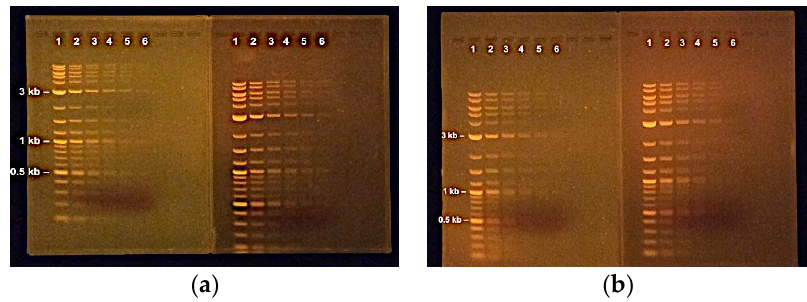
Figure 5. Use of recycled agarose. Pairs of 1% agarose/TAE gels were prepared under identical conditions and were electrophoresed in the same gel box for the same time. For each pair, the gel on the left contains recycled agarose; the gel on the right was made using new agarose. ( a ) The dehydrated gel pieces were sifted using the coarser mesh only. The recycled agarose required ~5min longer to dissolve than the new agarose, due to the presence of larger particles. ( b ) The dehydrated gel pieces were sifted through the finer mesh and required only ~40sec longer to dissolve than the new agarose. The two gels, recycled versus new, ran similarly. Overall, the coarser ground agarose particles provided good resolution, but the DNA migrated slower in comparison to finer used agarose particles or fresh reagent. This highlights an advantage of sifting. The DNA loaded is a 1 in 2 dilution series of Molecular Weight DNA standards (NEB Purple 1Kb ladder, Plus). Band sizes are 10, 8, 6, 5, 4, 3, 2, 1.5, 1.2, 1, 0.9, 0.8, 0.7, 0.6, 0.5, 0.4, 0.3, 0.2, 0.1 in kilobases.